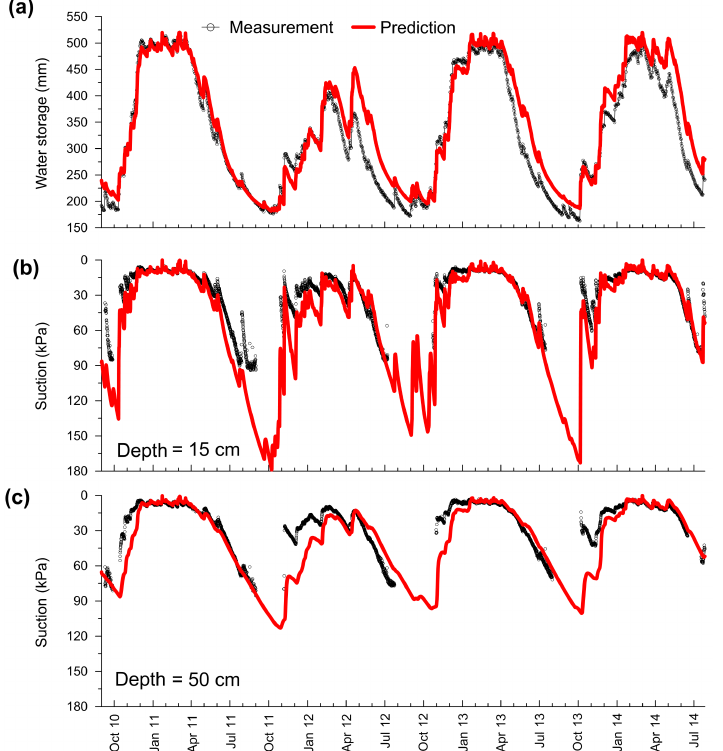
Figure 10. Back analysis of the observed layer hydrological behaviour by the IEM: (a) measured versus IEM-predicted water storage (WS); (b) measured versus IEM-predicted suction at depth of 15cm; (c) measured versus IEM-predicted suction at depth of